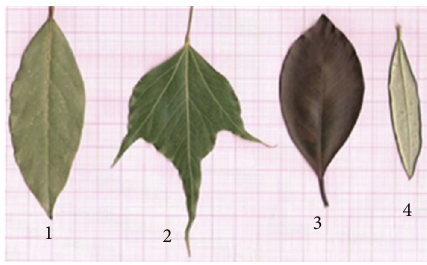
Figure 8: Placement of sample leaf.